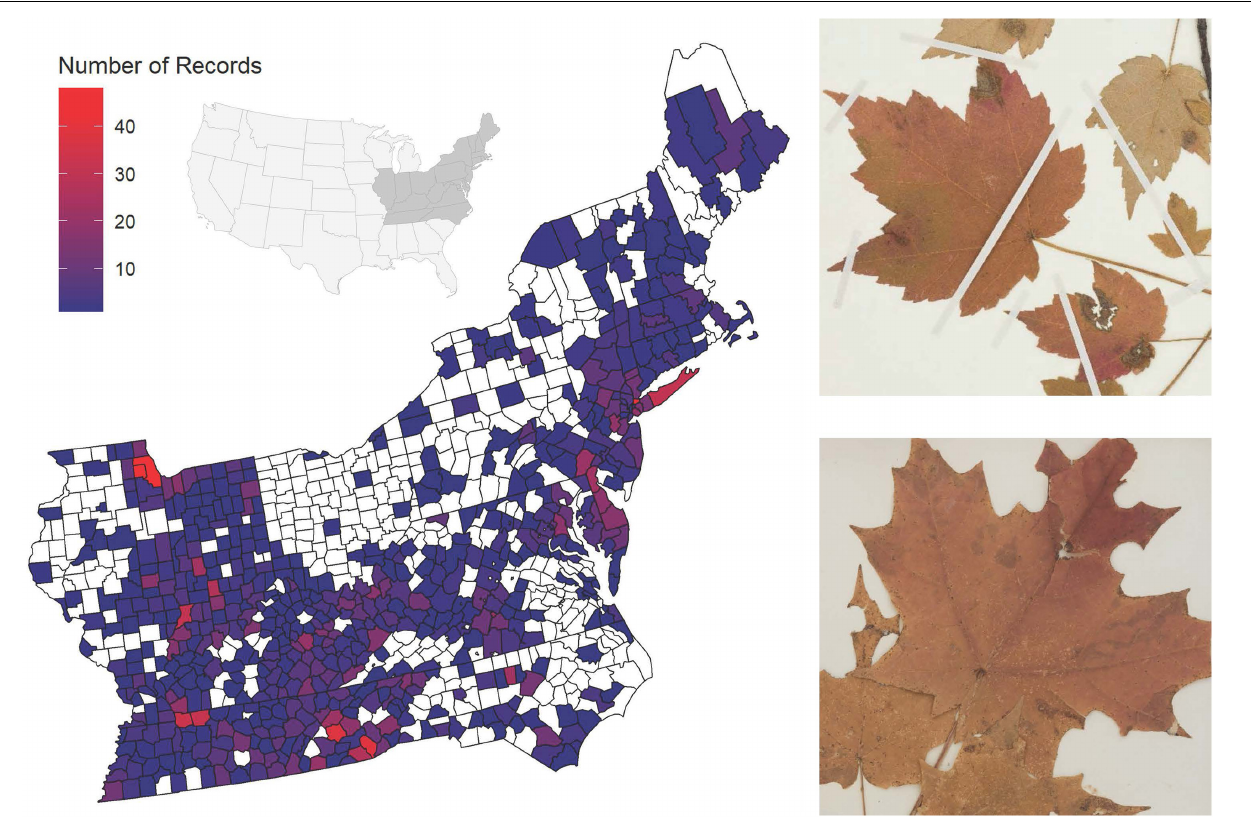
FIGURE 1 | (Left) Map of the eastern United States with counties colored by the number of herbaria specimens of Acer rubrum or Acer saccharum collected. The inset map details the location of the sampled states (dark gray) in the greater United States. White counties indicate counties with no specimens. (Right) representative images of a specimen with colored leaves and other damage from 1915 (top) and a specimen of colored leaves with herbivore chewing damage from 1891 (bottom).